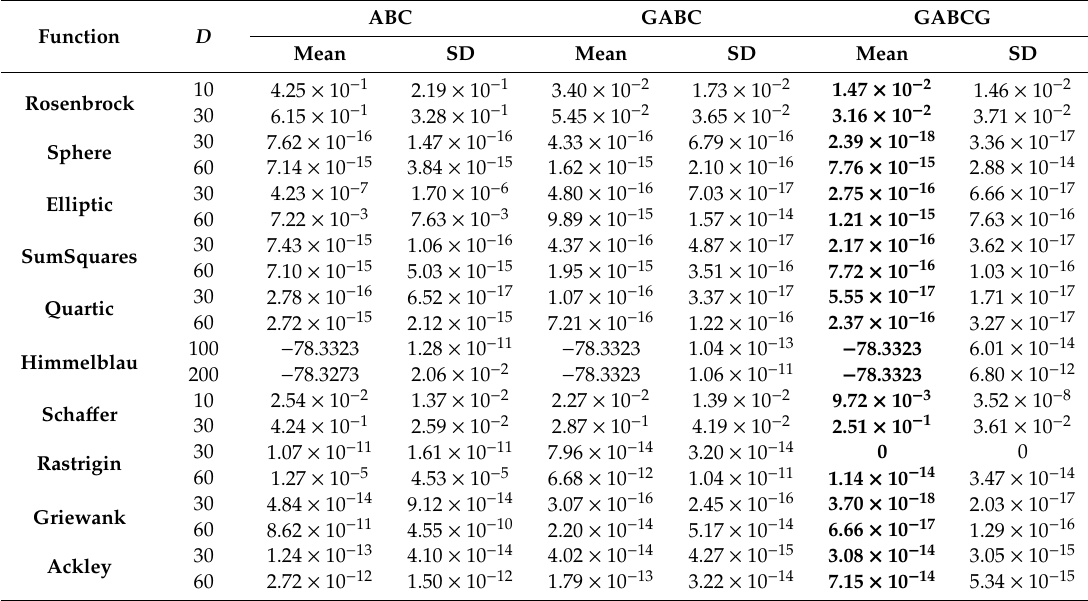
Table 3. Optimizations of benchmark functions by the artificial bee colony (ABC), Gbest-guided artificial bee colony (GABC), and GABCG algorithms.